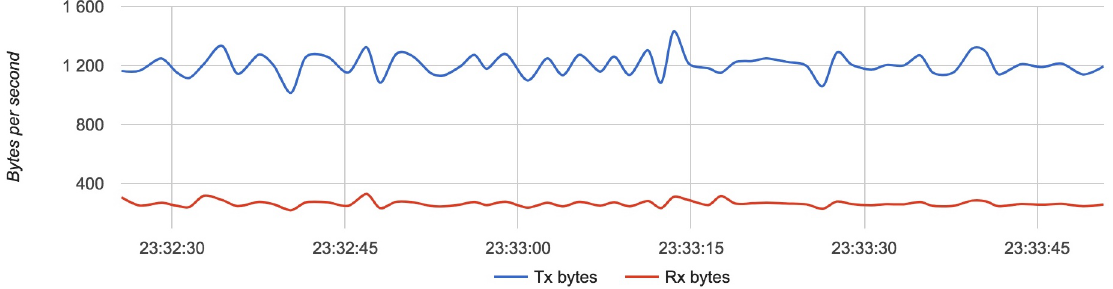
Figure 17. Bandwidth usage for a drone with Configuration 1.